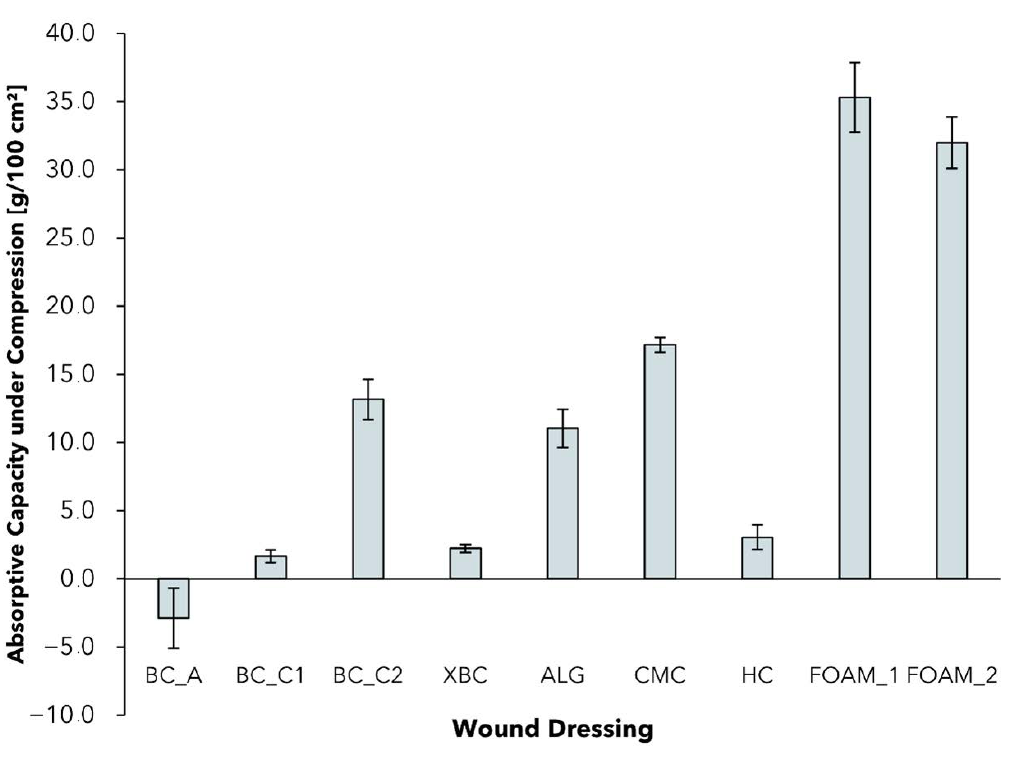
Figure 4. Absorptive capacity of different wound dressings after 0.5 h and under compression of 40 mmHg (mean ± SD; n = 5).